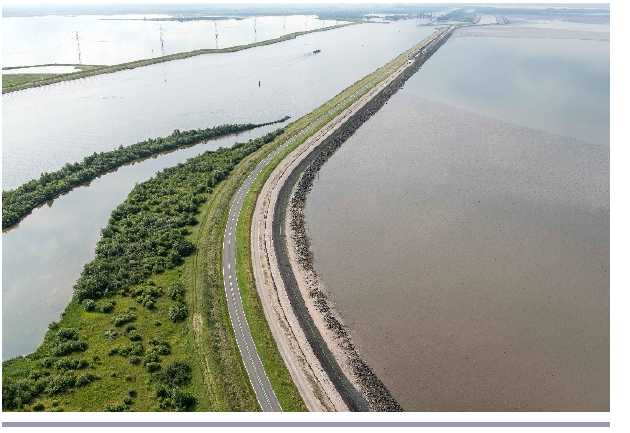
Fig. 2 . Oyster Dam (https://beeldbank.rws.nl, Rijkswaterstaat / Joop van Houdt).